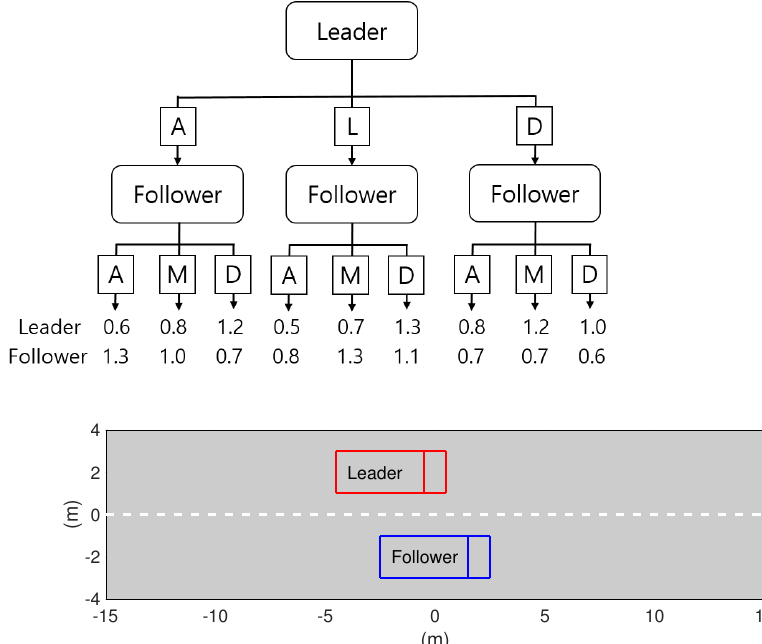
Figure 2. Simple example of the Stackelberg game in an overtaking